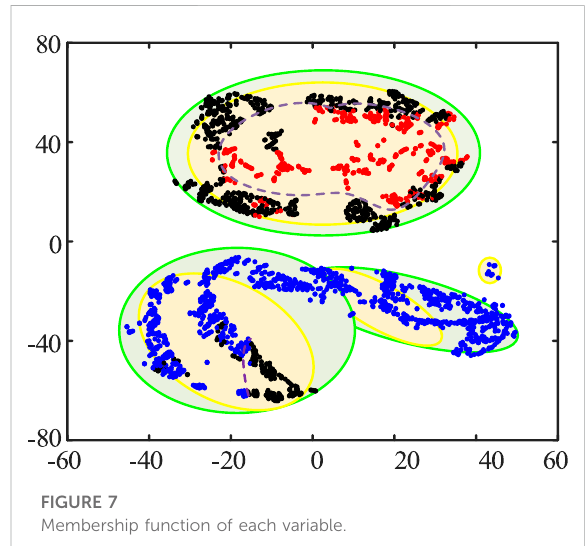
FIGURE 7 Membership function of each